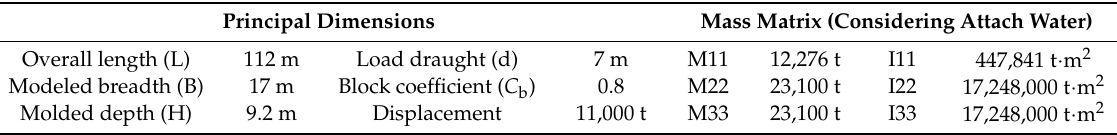
Table 6. Key parameters of the ship.